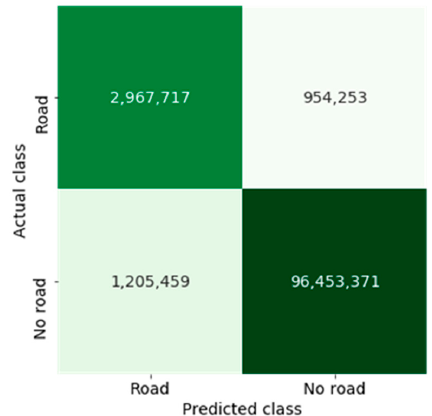
Figure 6. Confusion matrix obtained by configuration 5 trained on the full dataset. Note: The IoU score metric monitored during training does not consider True Negatives (TN); therefore, TN had no impact on the network’s training evolution.